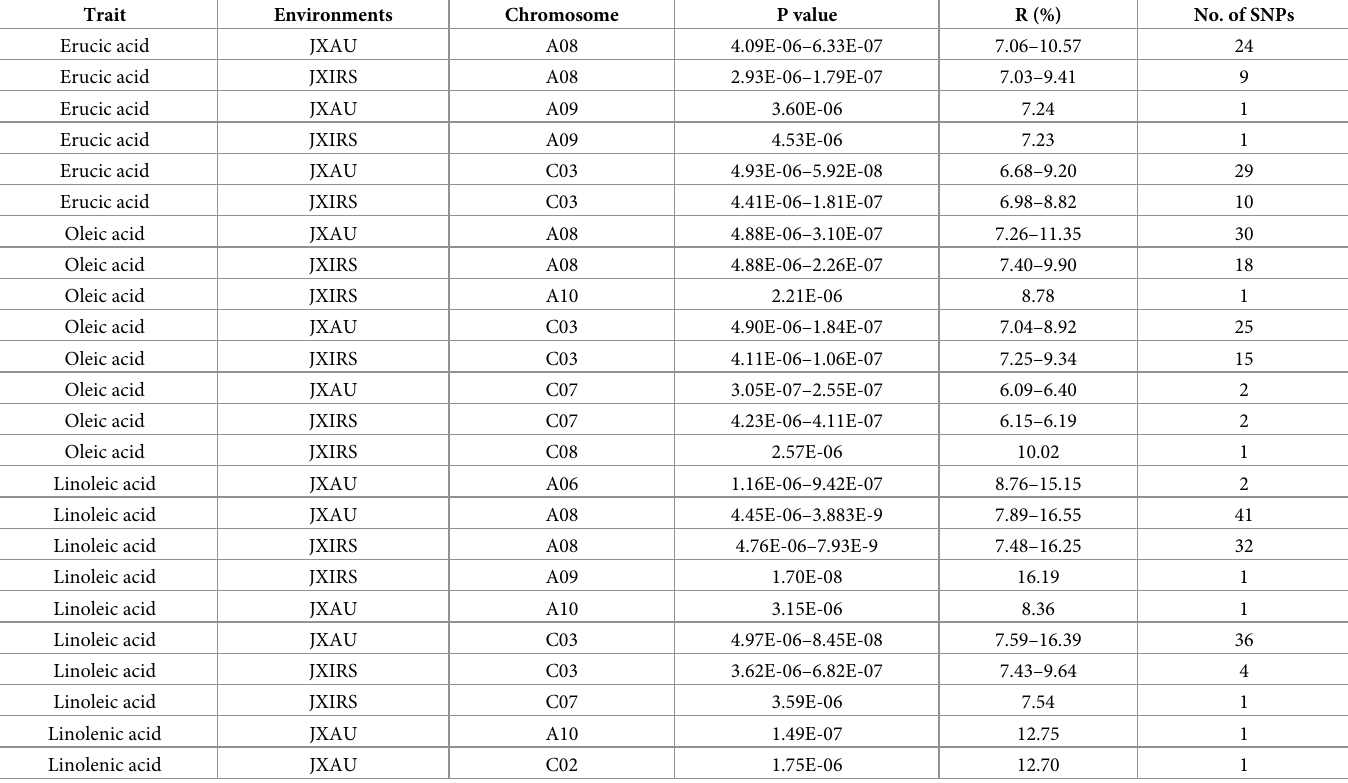
Table 4. Summary of SNP loci associated with four fatty acid composition in B . napus